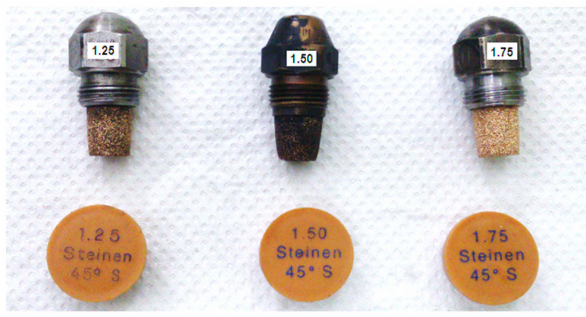
Figure 3. Solid atomizer type nozzles with 45 ˝ spray